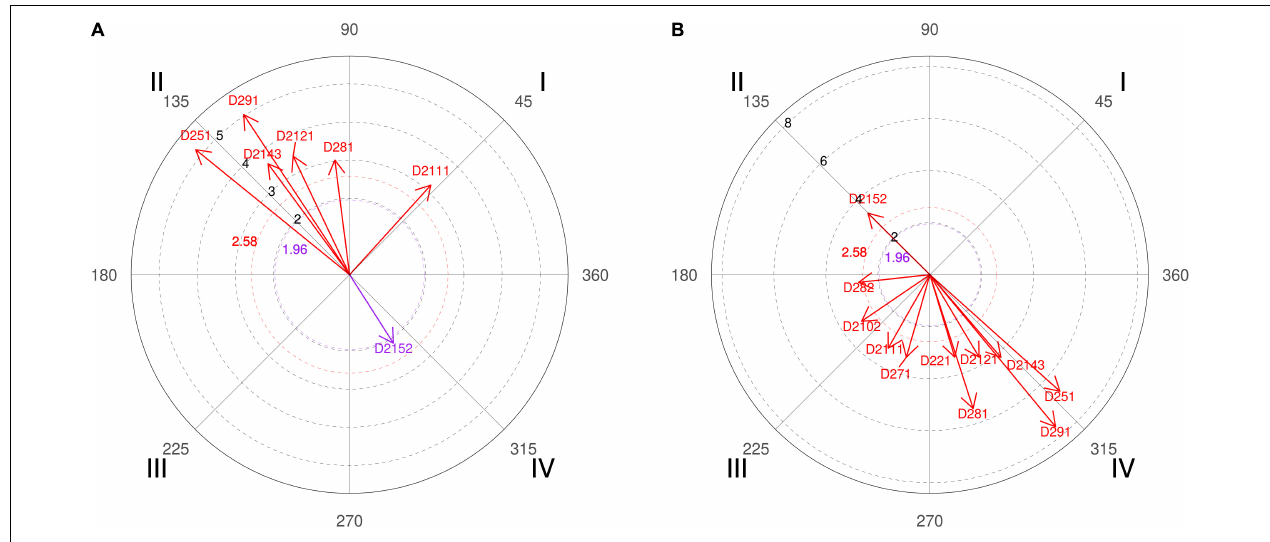
FIGURE 8 | (A,B) Relationship of conditioned behaviors that present a significant relationship with the focal behaviors “favorable evaluation” and “unfavorable evaluation” analyzing question 13 of the in-depth interviews. In “favorable evaluation,” a total of 7 significant vectors were detected, and in the “unfavorable evaluation,” a total of 11 significant vectors were